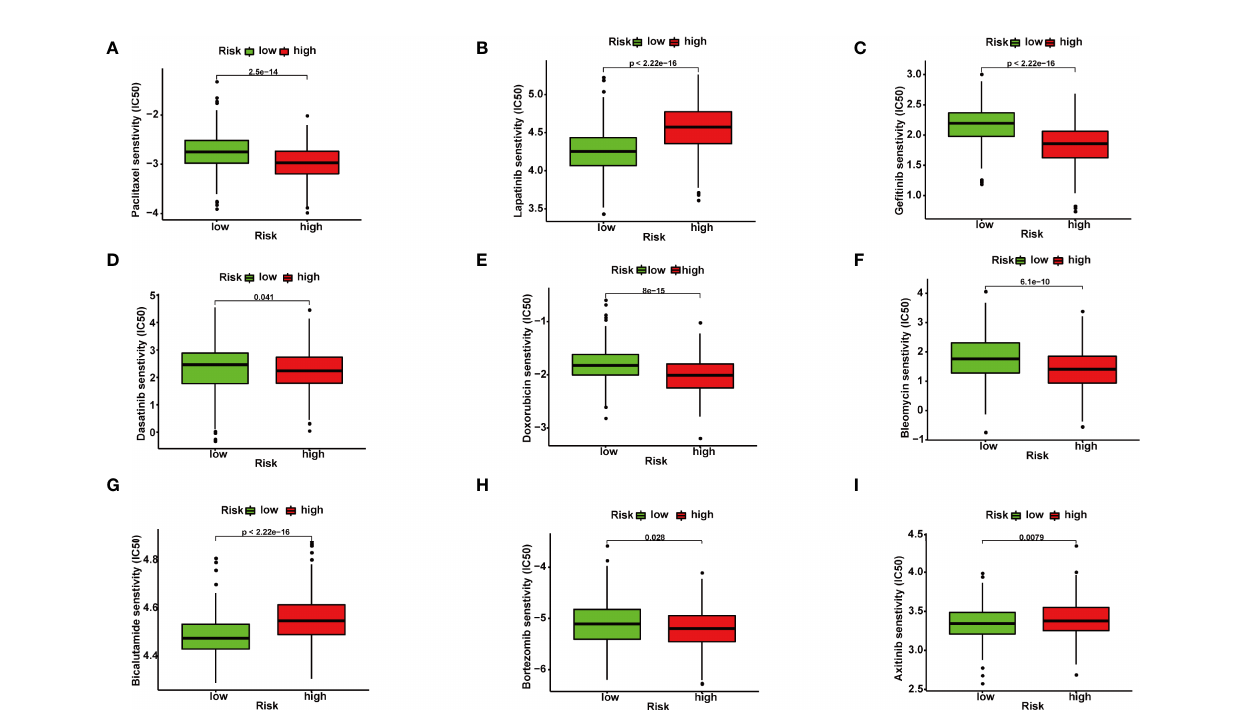
FIGURE 4 | Correlation between ferroptosis-related gene (FRG) signature and drug sensitivity. Box plots for estimated IC50 of drugs between high- and low-risk BRCA patients. Paclitaxel (A) , Lapatinib (B) , Ge fi tinib (C) , Dasatinib (D) , Doxorubicin (E) , Bleomycin (F) , Bicalutamide (G) , Bortezomib (H) , Axitinib (I) .